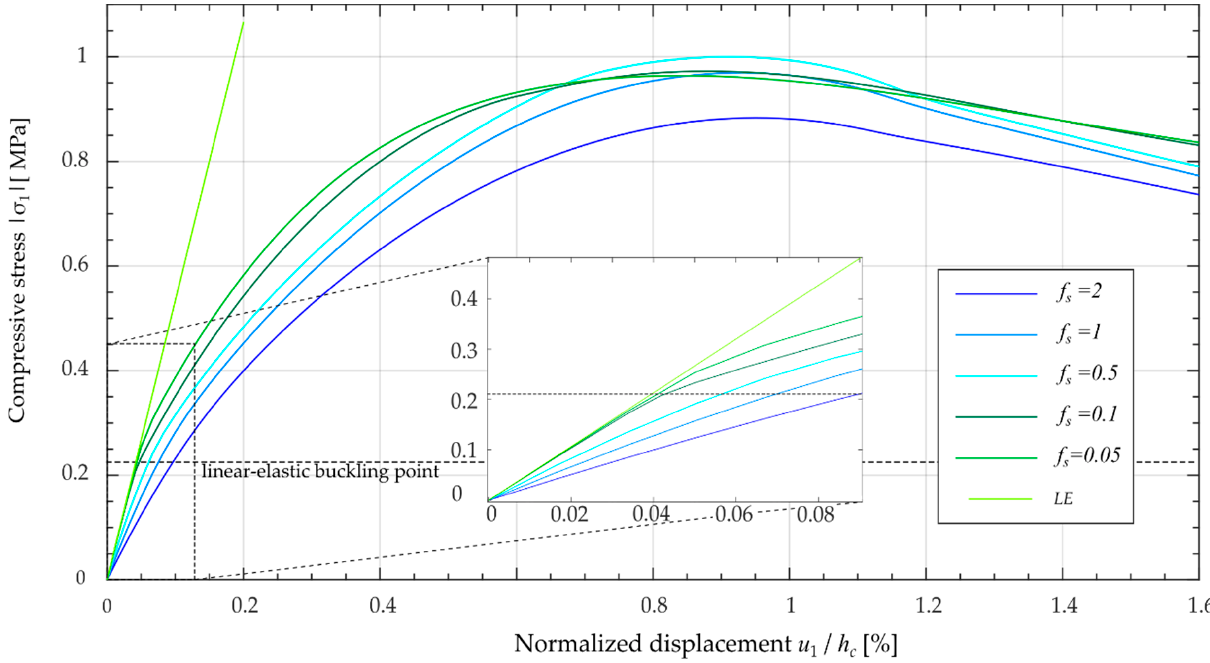
Figure 3. Effect of geometric imperfection on stress/strain behavior of the structure using different scaling factors f s for the first buckling mode.